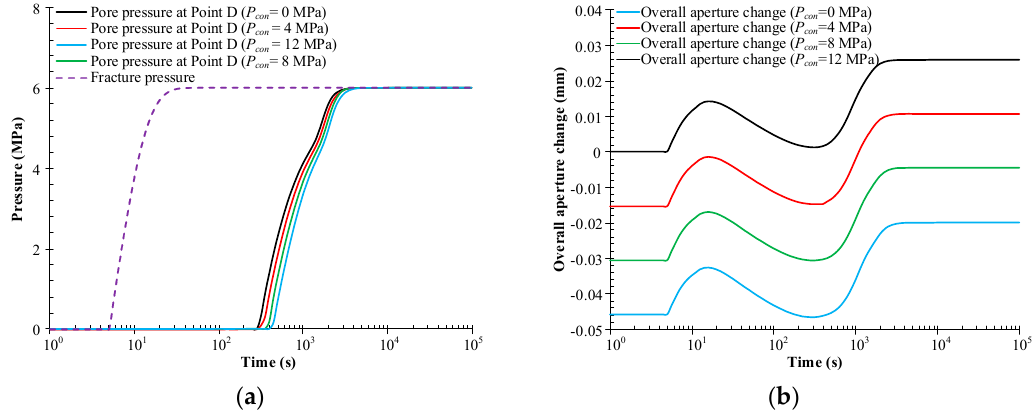
Figure 16. Evolution of pressure and aperture change for different confining pressures. ( a ) Fracture pressure and pore pressure at Point D; ( b ) overall facture aperture change.